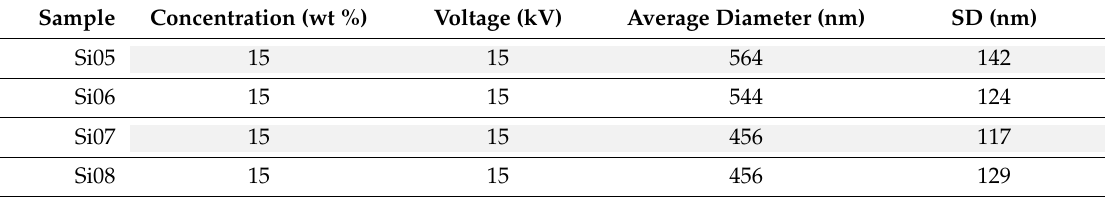
Figure 5. SEM images of graft type PUSX nanofibers. ( a ) Si05, ( b ) Si06, ( c ) Si07, ( d ) Si08 under optimized conditions. (Magnification: 2000, DMF:MEK = 64:36). Table 4. Diameters of graft type PUSX nanofibers under optimized spinning